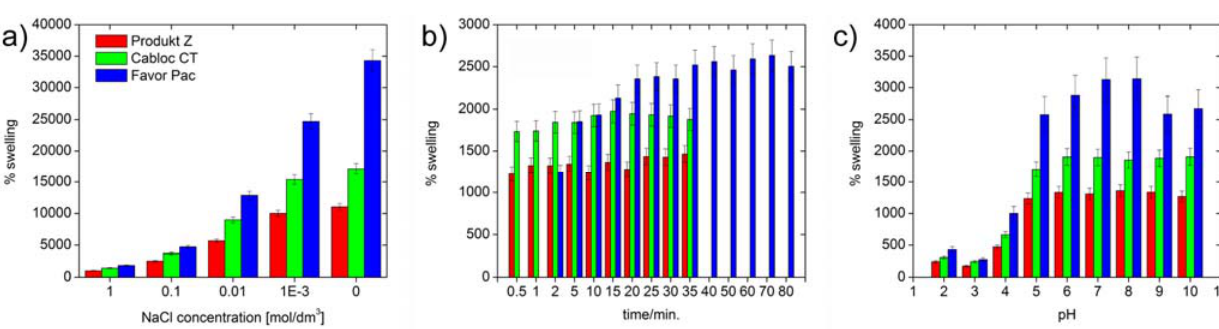
Figure 5. Swelling of the three polymers in deionized water as a function of time: a) maximum degree of swelling vs. ionic strength, b) swelling rate for 0.5 M NaCl. Compare Figure 4 for swelling in pure water, c) maximum swelling at different pH